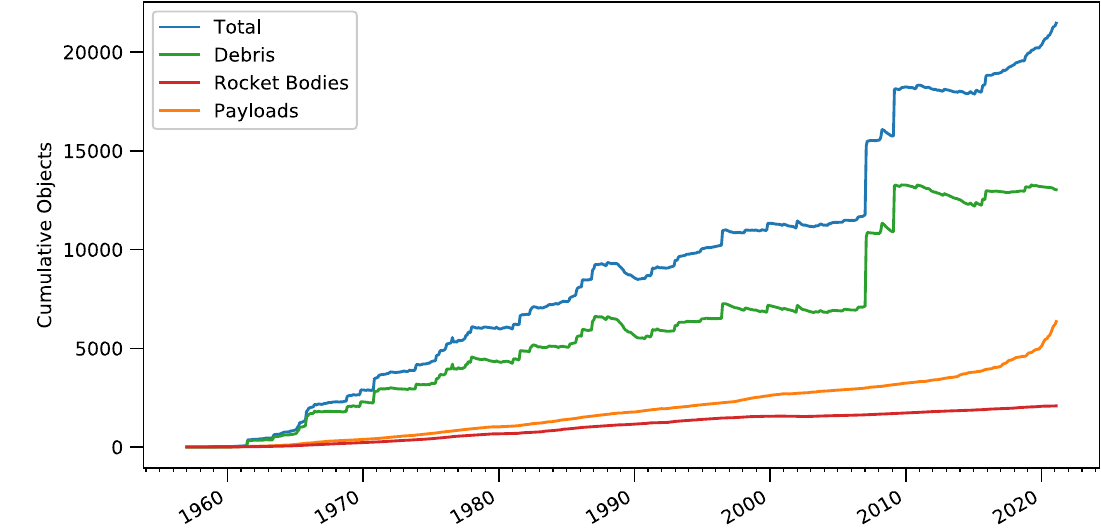
Figure 1. Cumulative on-orbit distribution functions (all orbits). Deorbited objects are not included. The 2007 and 2009 spikes are a Chinese anti-satellite test and the Iridium 33-Kosmos 2251 collision, respectively. The recent, rapid rise of the orange curve represents NewSpace (see "Methods").